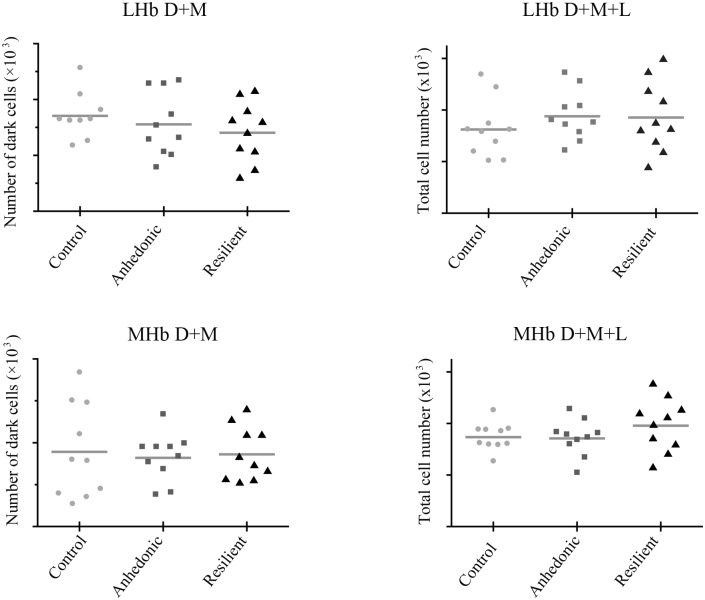
Stereological estimates of total c-Fos-ir in the habenular complexes.The estimates of total c-Fos-ir in the lateral (A) and medial (B) habenular complexes analysed with stereology. In plot A and B number of cells counted in the LHb as the sum of dark and medial c-Fos-ir and the sum of dark, medial and light c-Fos-ir, respectively. In plot C and D number of cells counted in the MHb as the sum of dark and medial c-Fos-ir and the sum of dark, medial and light c-Fos-ir, respectively. One-way ANOVA. LHb, lateral habenula; MHb, medial habenula.